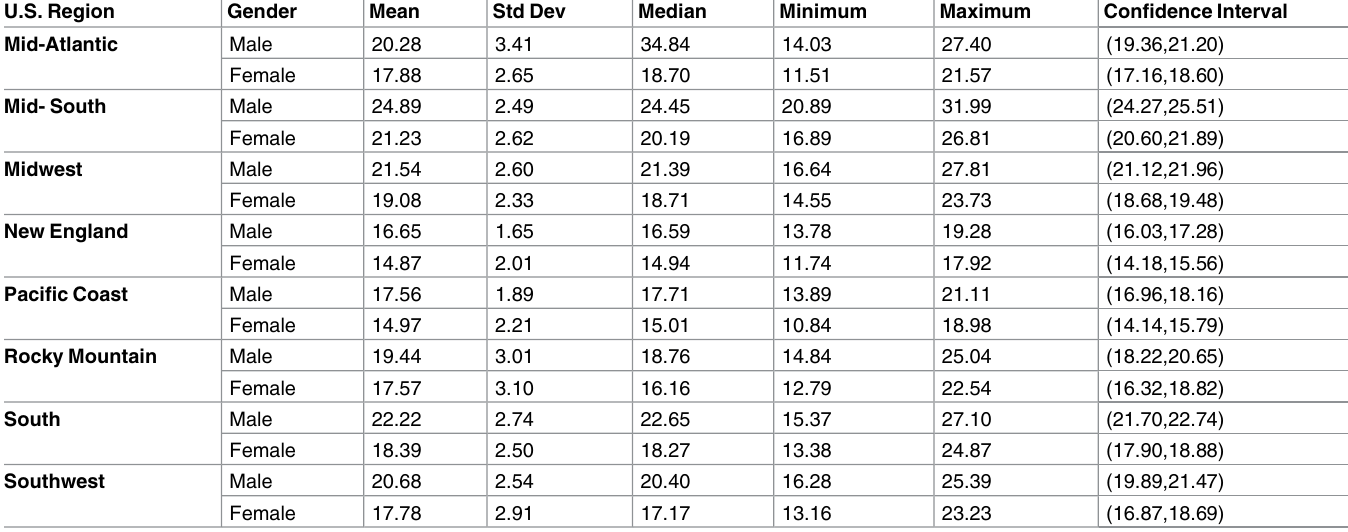
Table 10. Summary statistics of mean percentage of daily smokers for males and females in 8 U.S. geographic regions, 1999–2012. U.S.